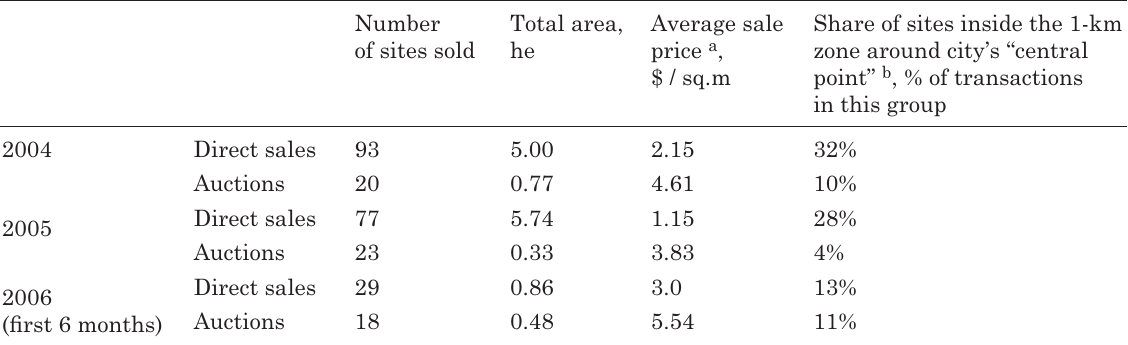
Table 3. Results of “direct sales” and auctions, Osh, 2004 – six months of 2006